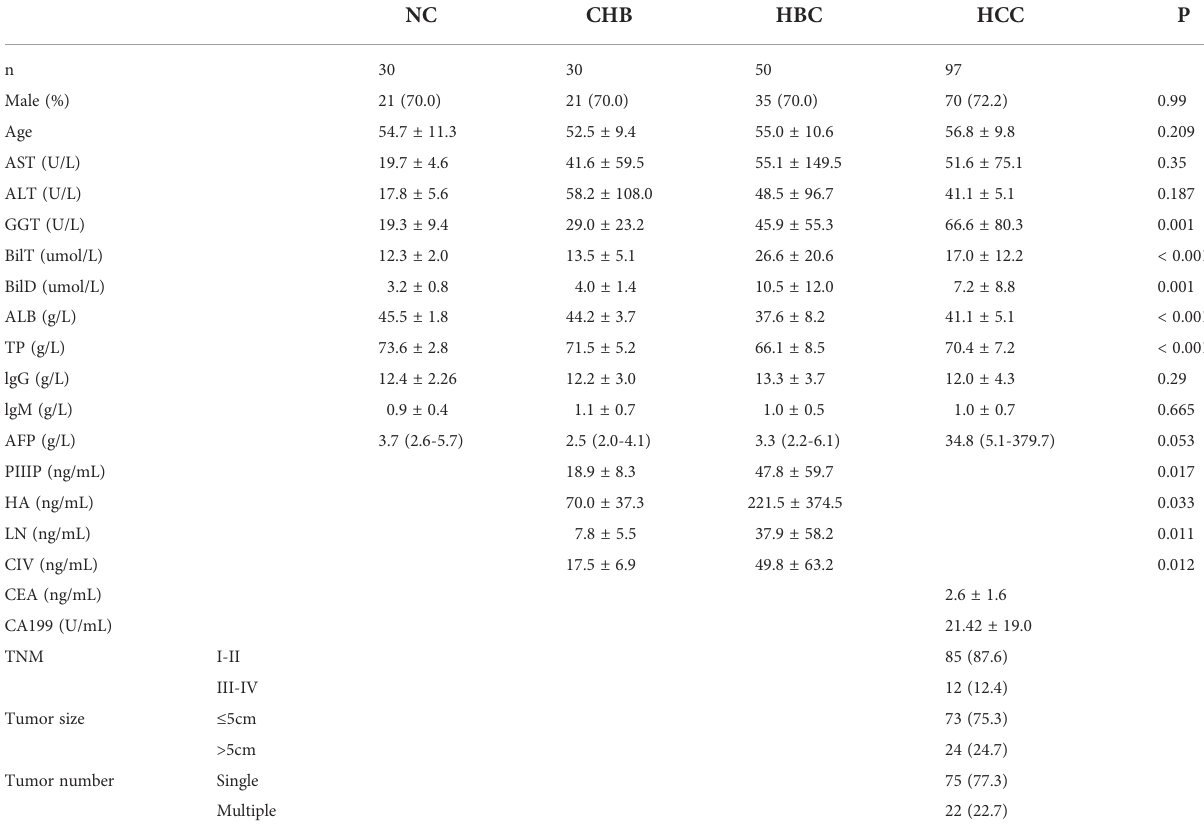
TABLE 1 Clinical characteristics of